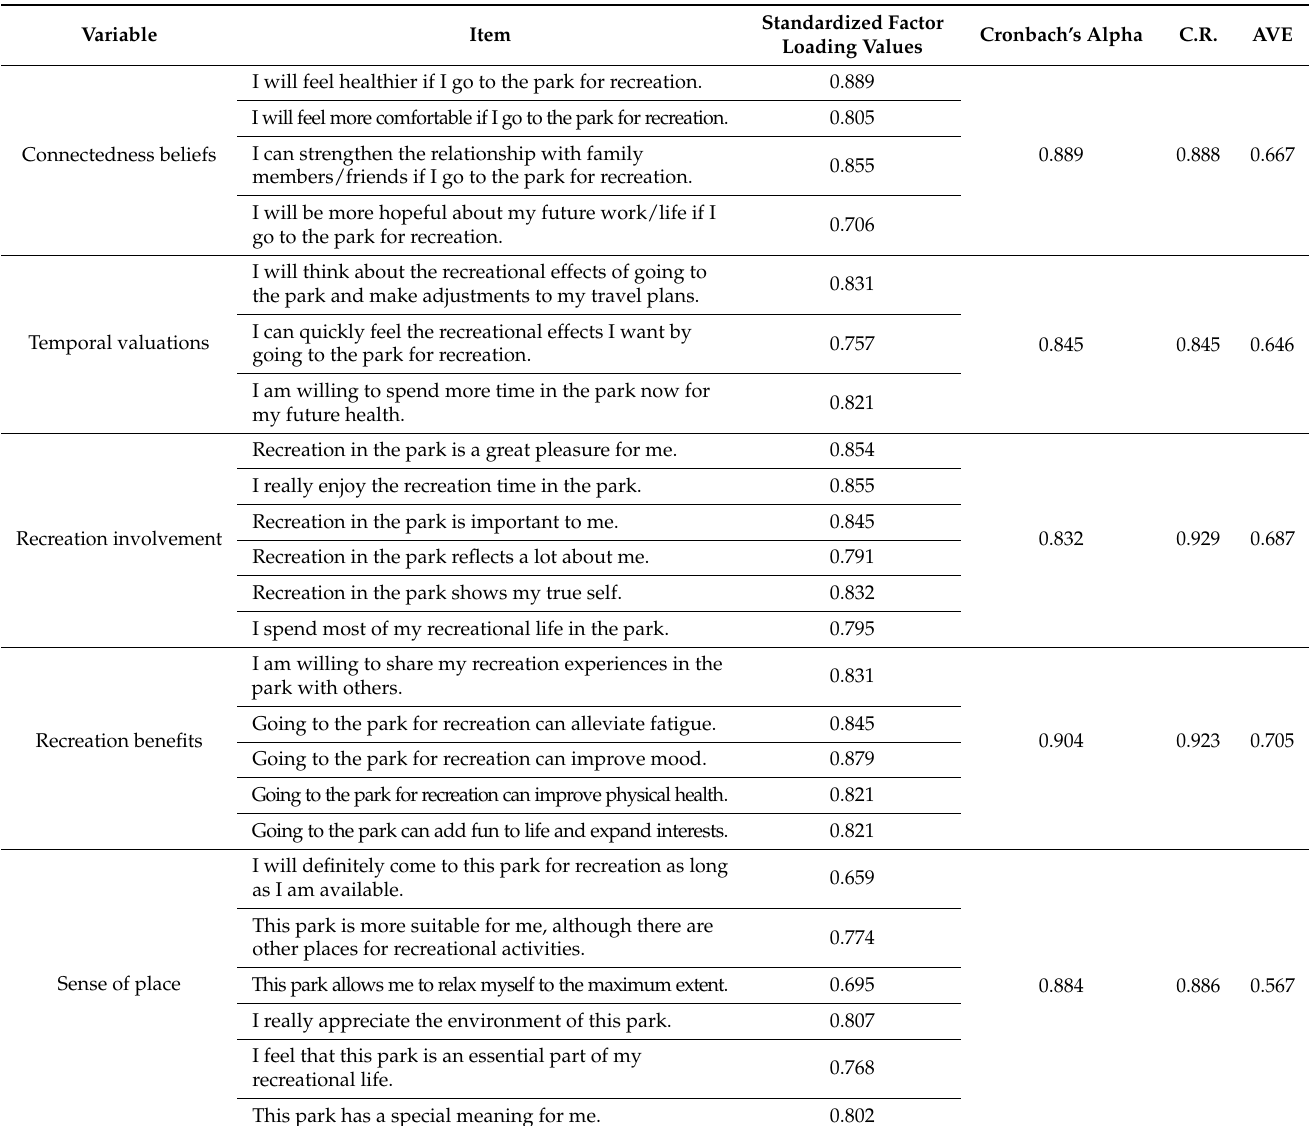
Table 3. Results of reliability and convergent validity